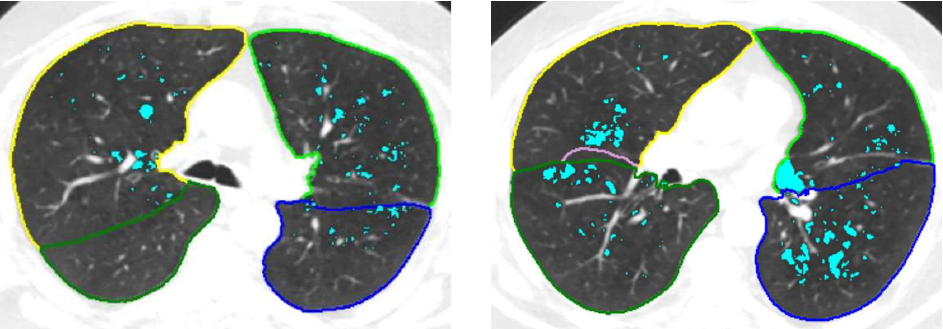
Figure 1. Automatic 3D segmentation of lung and lobe contours and quantitative analysis of emphysema in a 65year-old former smoker using the AI-RAD Companion (Siemens Healthinners) solution. The contours of the left lower lobe are blue and those of the right lower lobe are dark green. The contours of the right upper lobe are yellow and those of the left upper lobe are light green. The voxels that have an attenuation value of less than 950 HU (emphysema) are green turquoise.